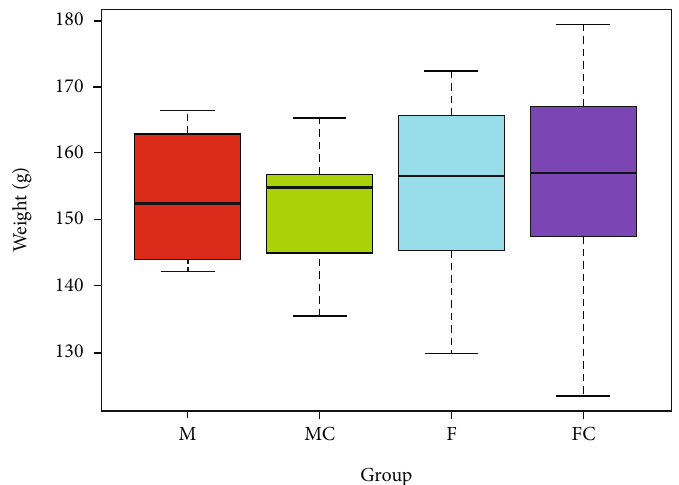
Figure 1: Comparison of rat weight among groups. M group: male healthy control group; F group: female healthy control group; MC group: male model control group; FC group: female model control group. N = 8 per